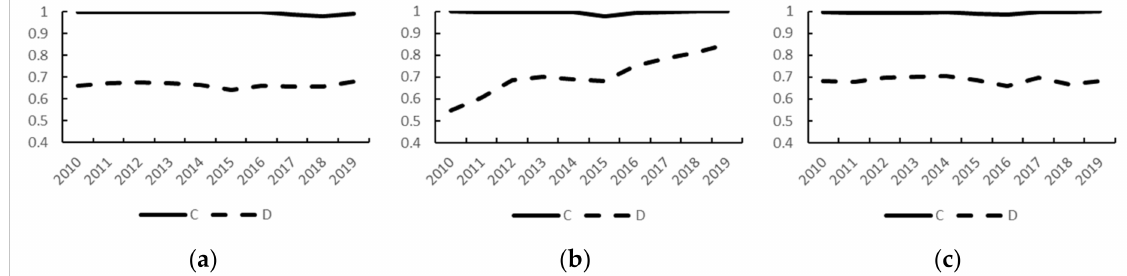
Figure 7. Coupling degree and coupling coordination degree evaluation results. ( a ) Equation (1A), ( b ) Equation (1B), and ( c ) Equation